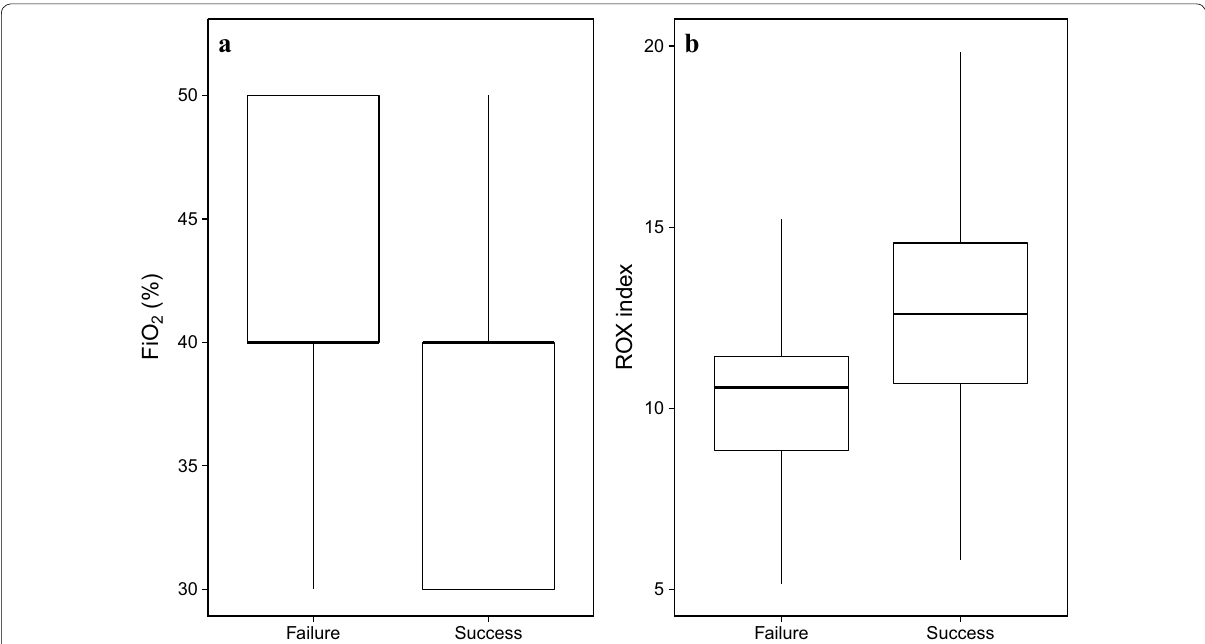
Fig. 2 Last physiological parameters recorded at the bedside under high‑flow nasal oxygen therapy before the first separation attempt. a Box‑plot of FiO 2 according to the success or failure of the first separation attempt ( p 0.02). b Box‑plot of the ROX index according to the success or failure of = the first separation attempt ( p =